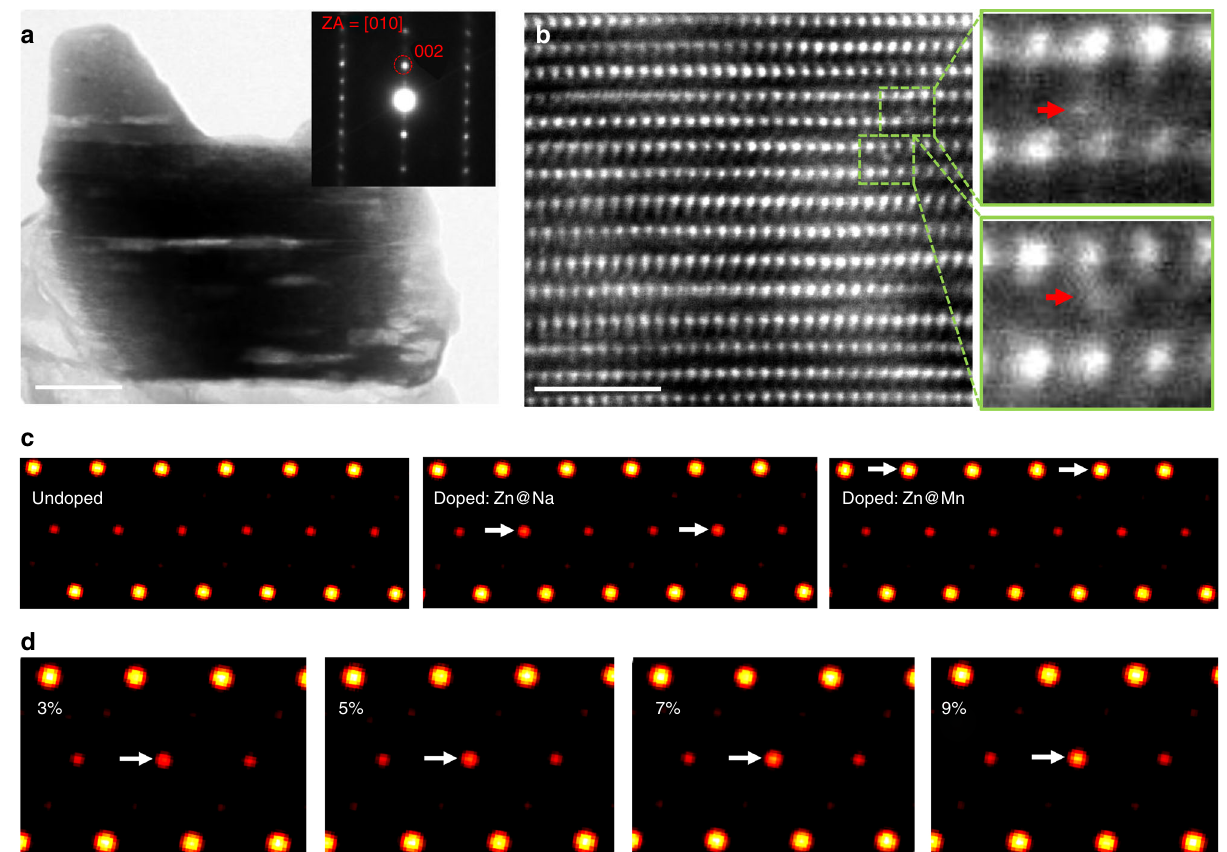
Fig. 4 Microscopy structure investigation of NLMO-Zn. a Bright- fi eld TEM image of the particle along the [010] projection. Inset shows the selected area diffraction pattern from the particle. b HAADF-STEM image of NLMO-Zn. c Simulated HAADF images in the [010] projection of the three cases: undoped NLMO, 5%-Zn occupying the Na site in NLMO-Zn, and 5%-Zn occupying the Mn site in NLMO-Zn. d Simulated HAADF images showing the different contrasts by the variation of Zn-occupancy (3%, 5%, 7%, and 9% Zn in the Na